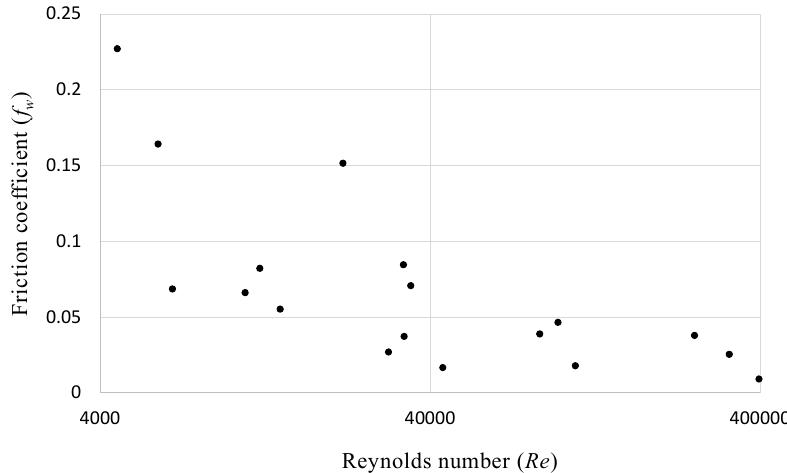
Figure 10. Computed coral friction coefficients for each wave/water condition versus Reynolds number.